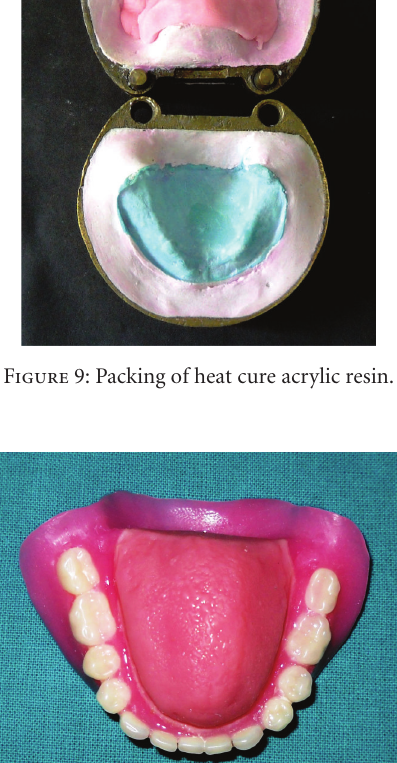
Figure 8: Packing of Molloplast-B material.